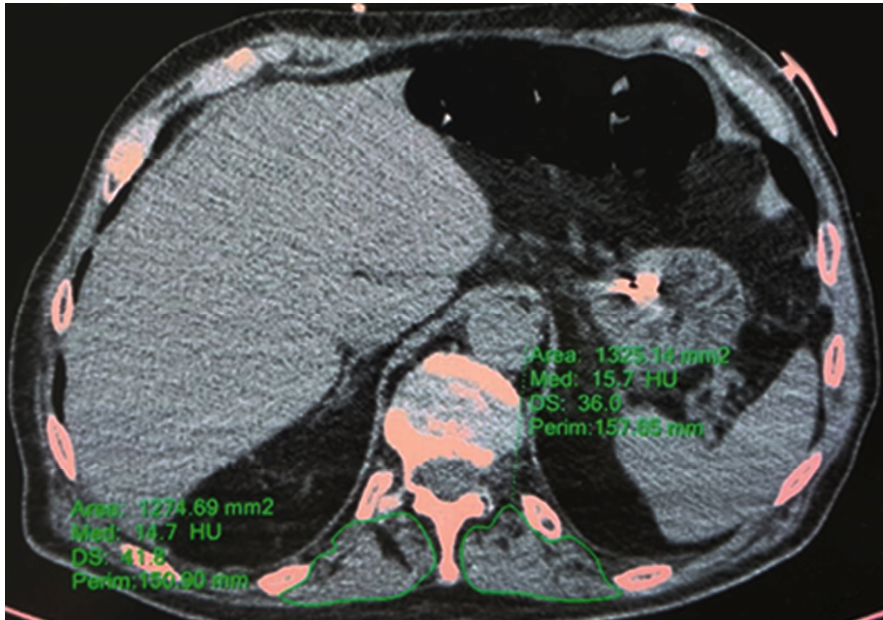
Figure 2. T12 paravertebral spinal muscle area and density . Credits: AUSL Romagna.